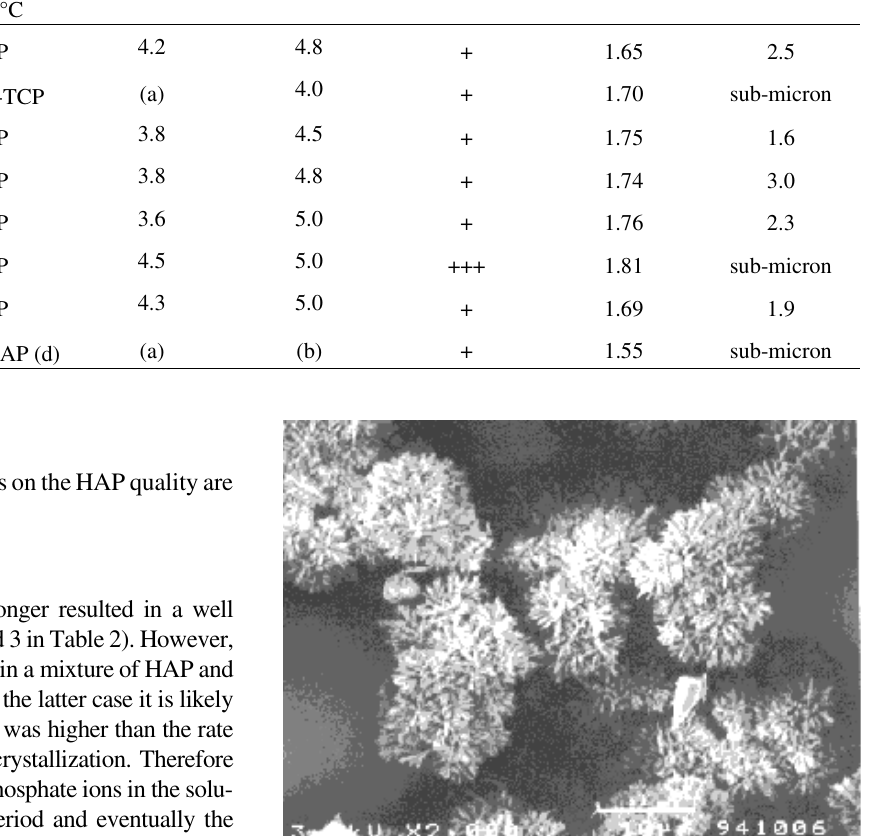
Table 2. Characteristics of the produced materials: main phases identified by X-ray diffraction, cristallinity indexes 1/ β , carbonate content, Ca/P molar ratios and primary particle sizes; (a) large peaks (low 1/ β ), with superposition; (b) superposition of HAP and β -TCP peak; (c) +, ++ and +++ indicate increasing concentrations; (d) HAP is present in a small amount.